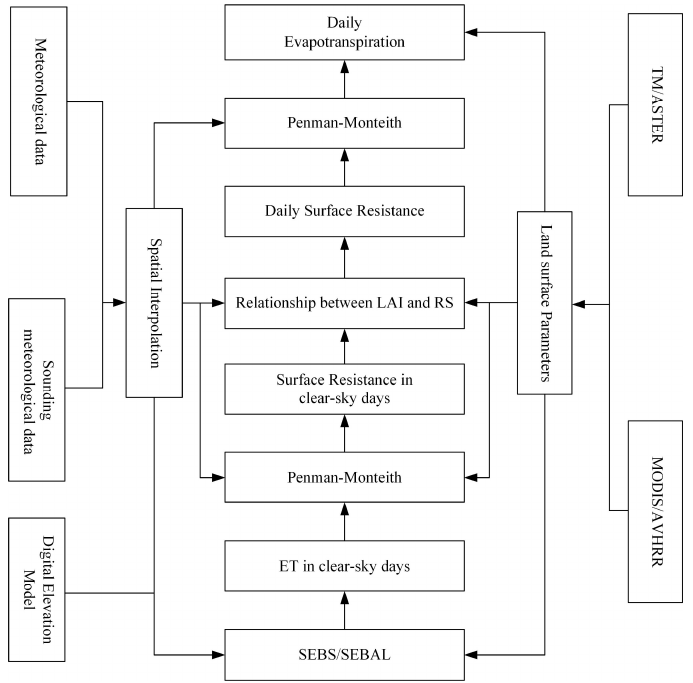
Figure 2. Flowchart of the key procedures embedded in ETWatch [22].